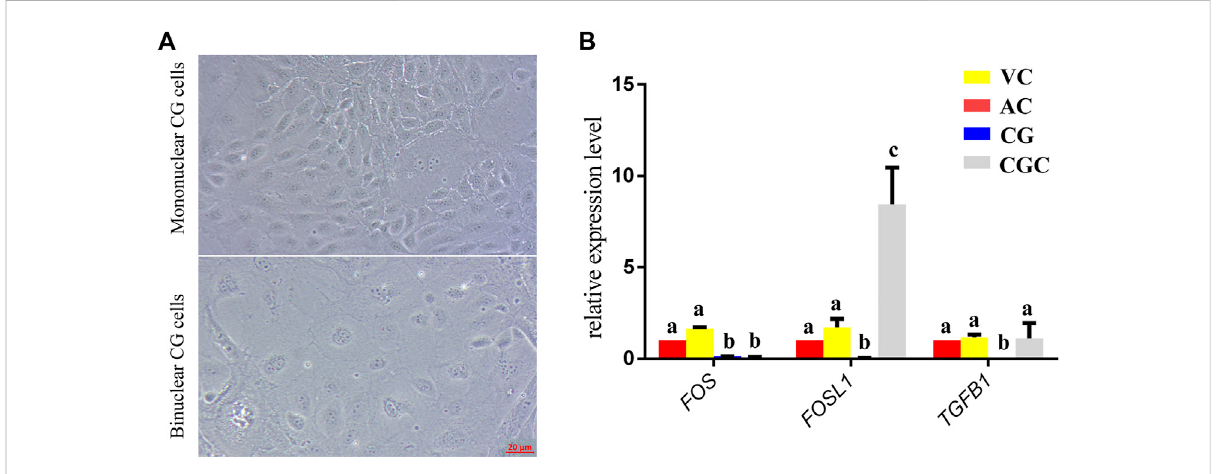
FIGURE 5 Invitro cultureandgeneexpressionofchorionicgirdle(CG). (A) Morphologyofchorionicgirdle(CG)cells,thepictureaboveismononuclearCG cells, below is binuclear CG cells, bar = 20 μ m. (B) qPCR results. Different letters indicate a signi fi cant difference ( p -value <